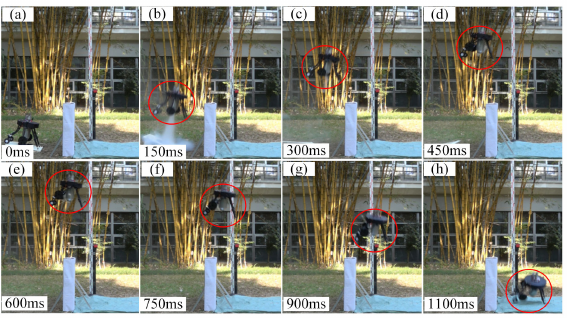
Figure 13. The time sequence of jumping robot’s process of jumping over